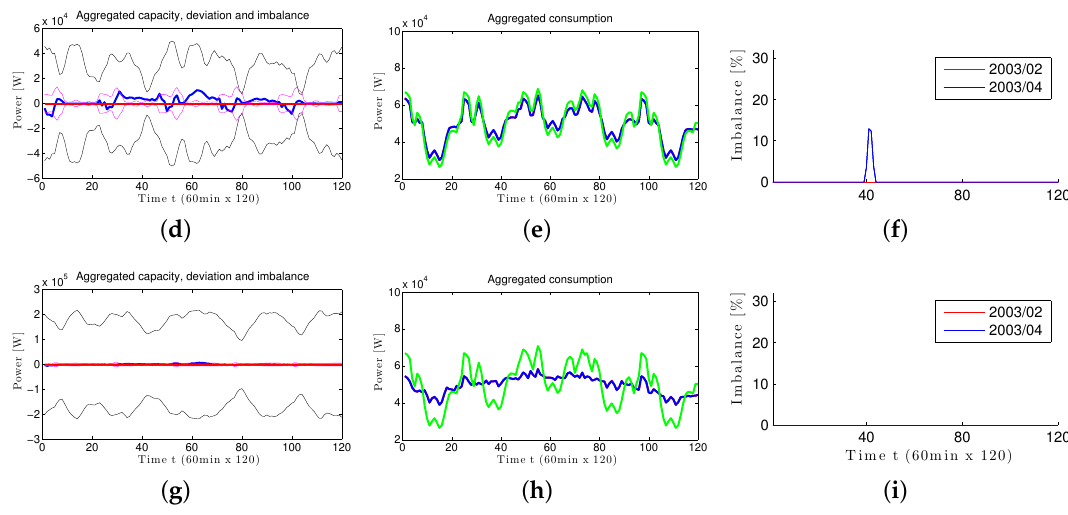
Figure 14. Augmented week-ahead coordination. Date: 2003/02. Rows indicate battery size: ¯ C ∈ { 0.3 × 700,700,3 × 700 } Wh . Left column: capacity, tolerance, deviation and compensated deviation. Middle column: actual, intended and appliance consumption. Right column: community imbalance (see main text for definition) for two different dates (2003/02 and 2003/04). Note: the figures have different scales in the y-axis for easier visualization. ( a ) ¯ C = 0.3 × 700 Wh